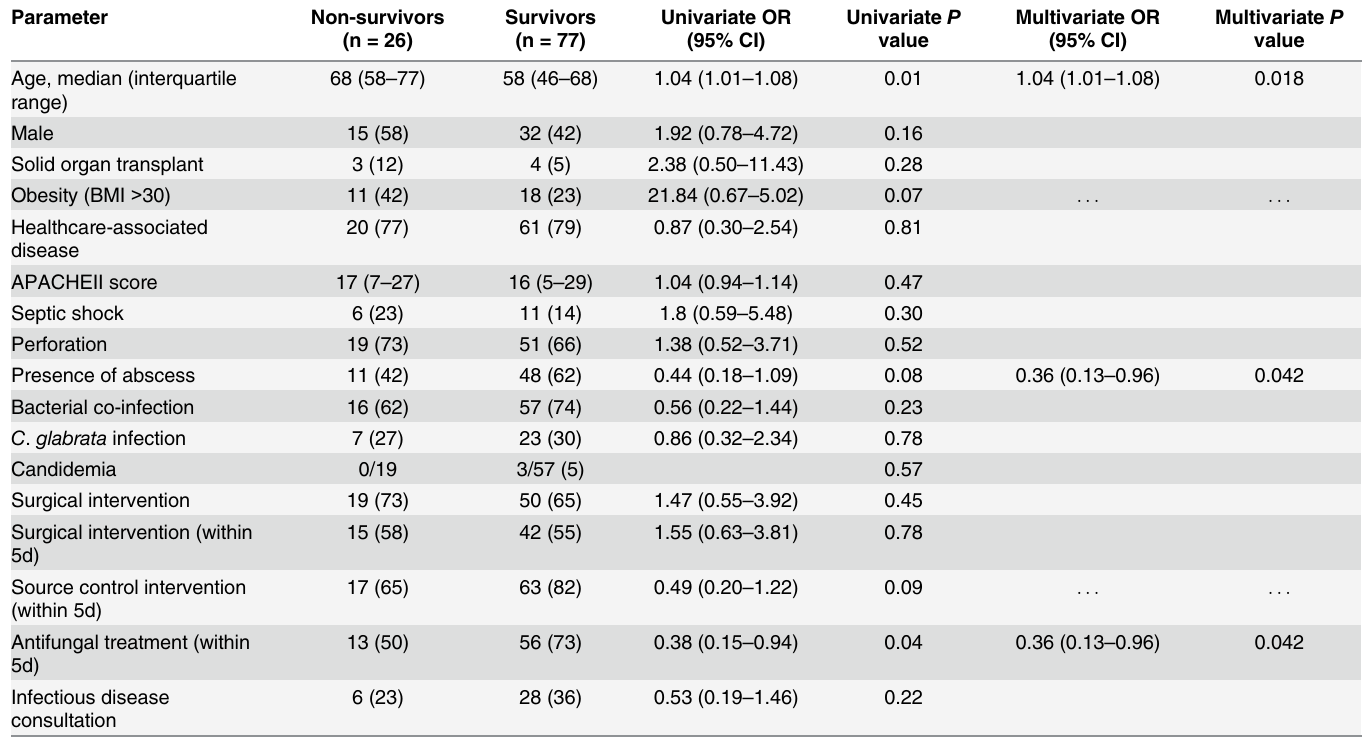
Table 5. Predictors of 100-day mortality for subjects with IAC stemming from GI tract sources.